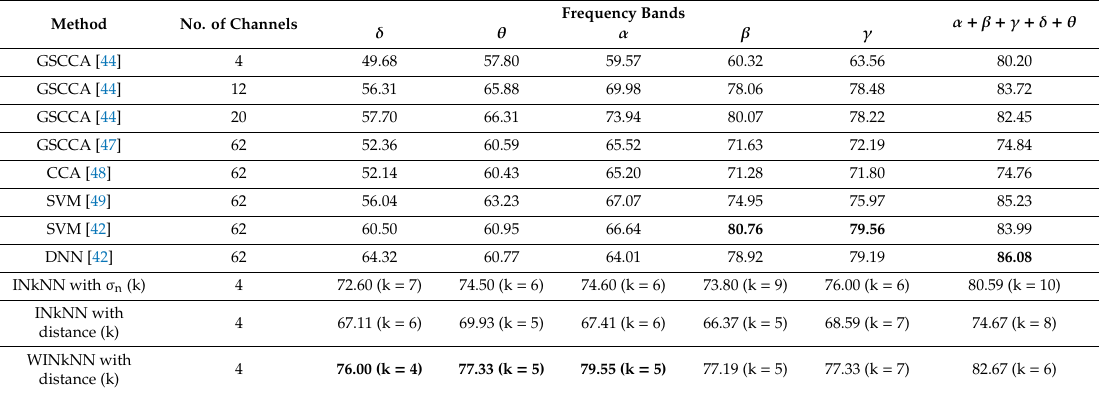
Table 3. Results of the WINkNN classifier on the SEED dataset comparatively with alternative methods from the